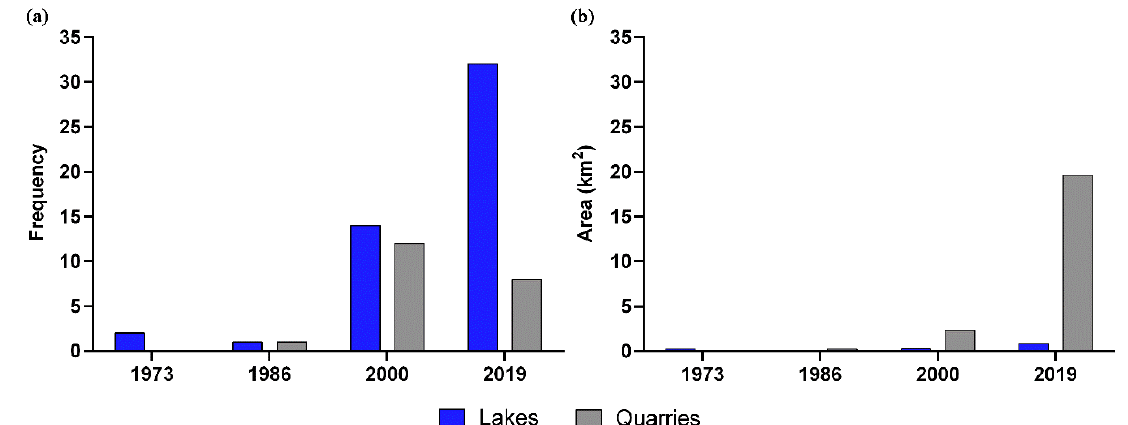
Figure 7. Comparison of the lakes and quarries around the Yueya Lake and the Gulian’he coal mine for 1973, 1986, 2000, and 2019: ( a ) frequency and ( b ) surface area.